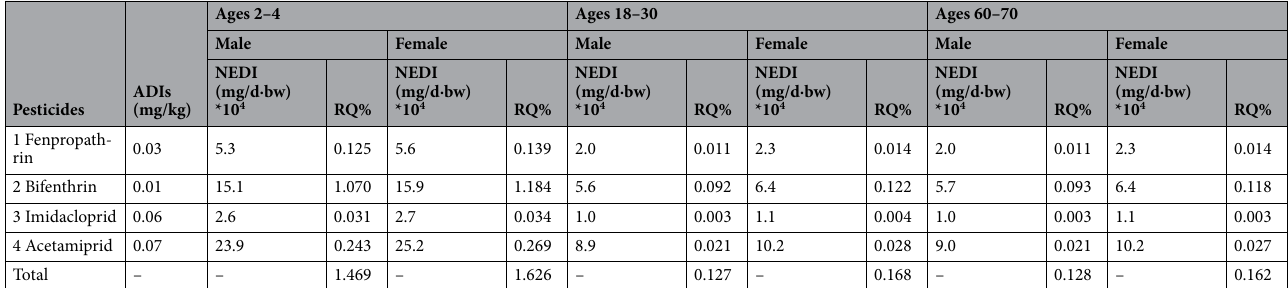
Table 5. The NEDIs and RQs% of 11 pesticides in apricot of different age groups in